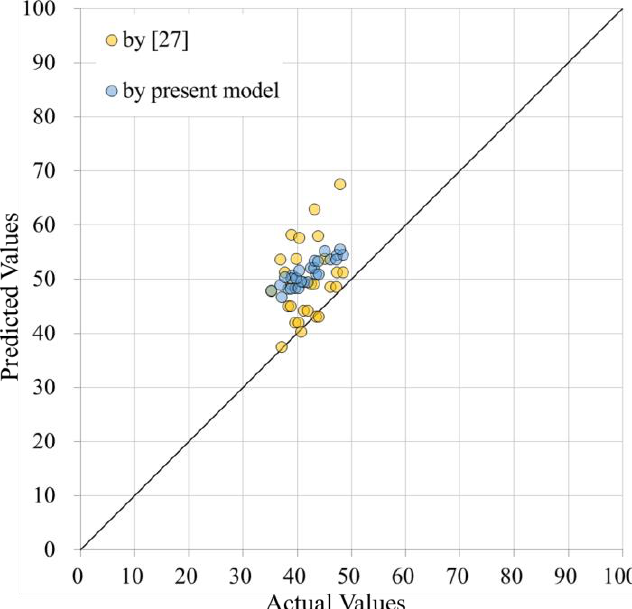
Figure 4. Comparison of the predicted values with the actual 28-day compressive strength of concrete in which fly ash was admixed [25] (Unit: MPa).